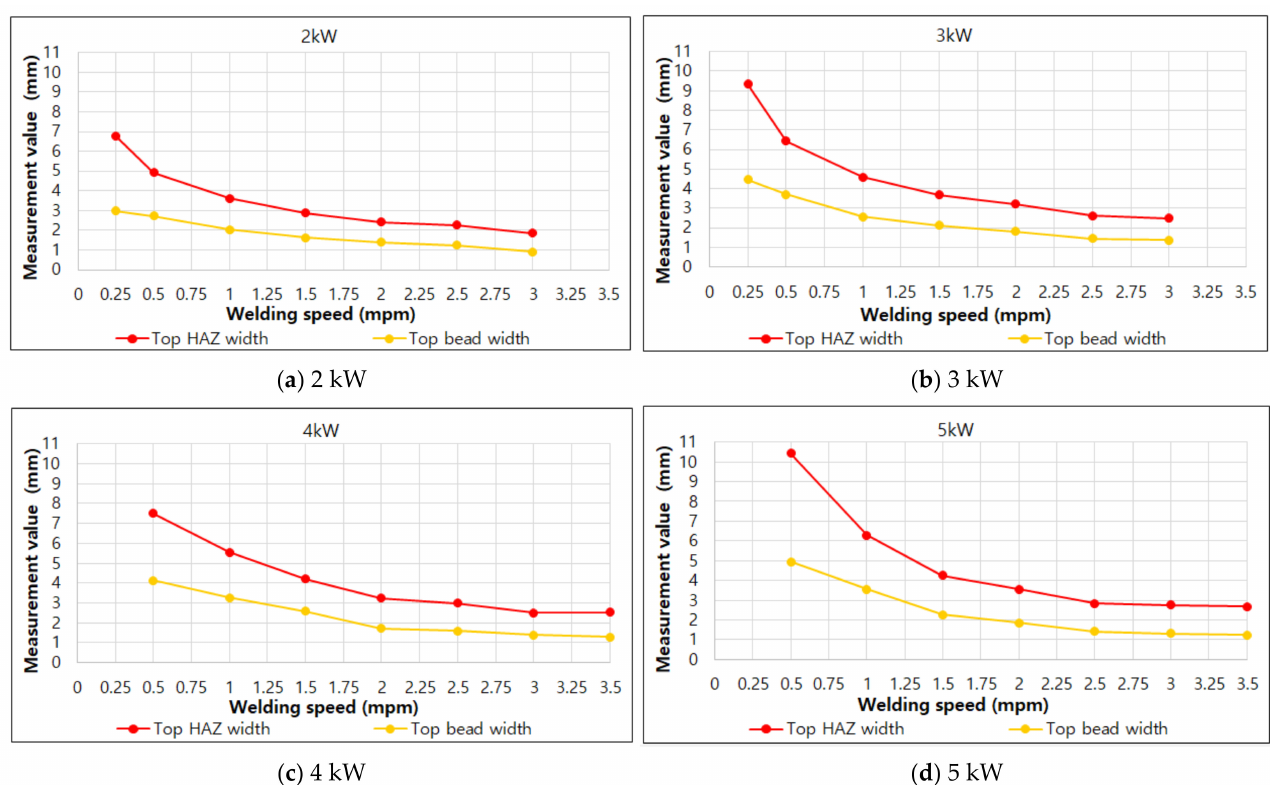
Figure 5. Results of top HAZ width and top bead width according to welding speed under each laser output condition.